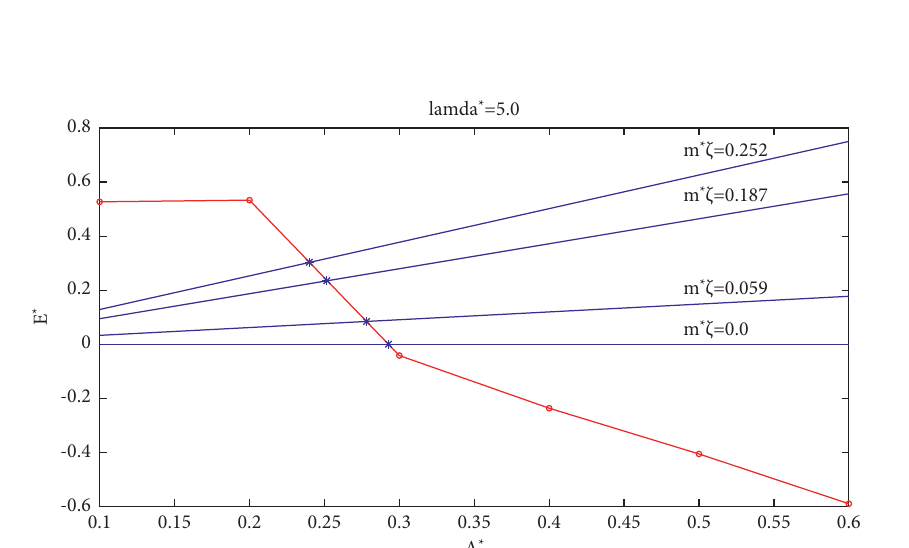
Figure 15: Prediction of amplitude response A ∗ at different mass damping when λ ∗ � 5 . 0.